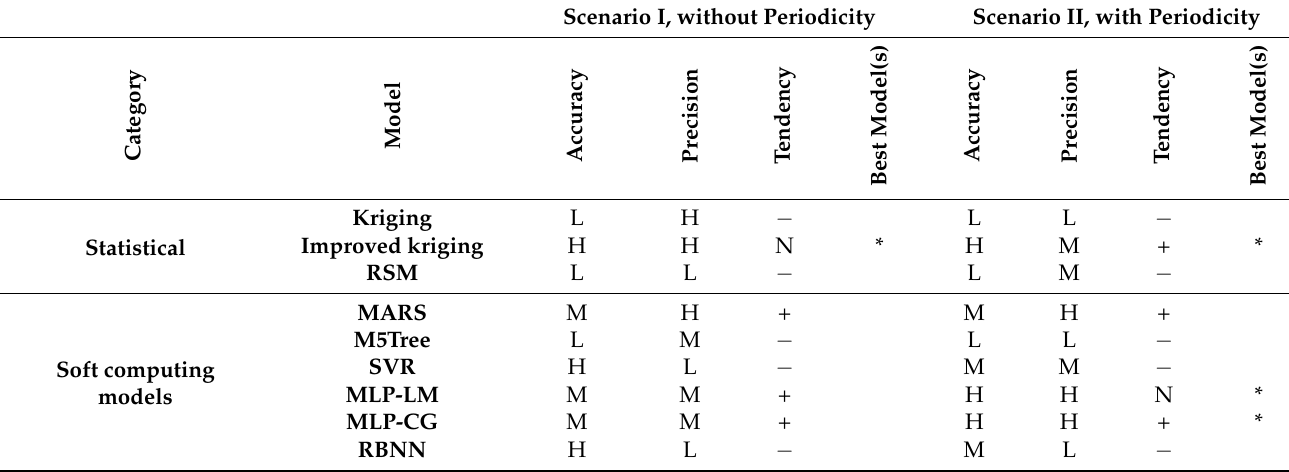
Table 6. The general performance of the applied predictive models in terms of accuracy, precision, and tendency for Antakya Station in the testing